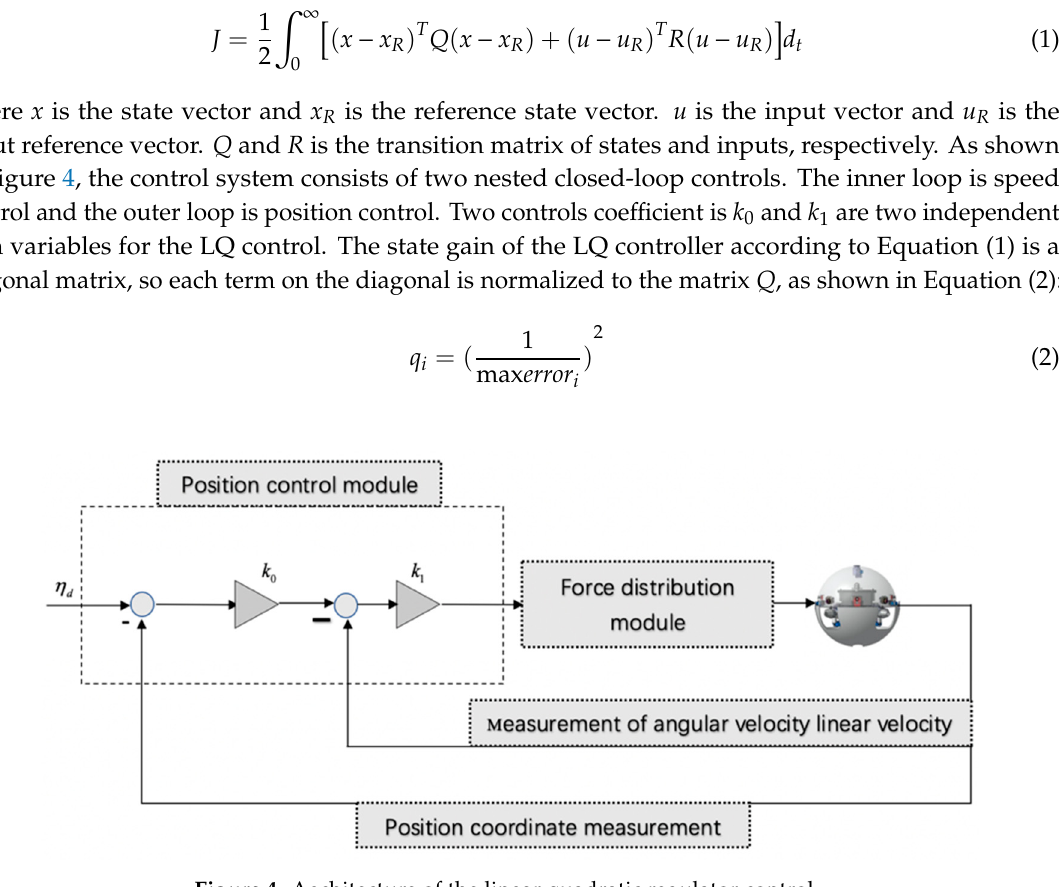
Figure 5. Aechitecture of the state feedback linearization controller.